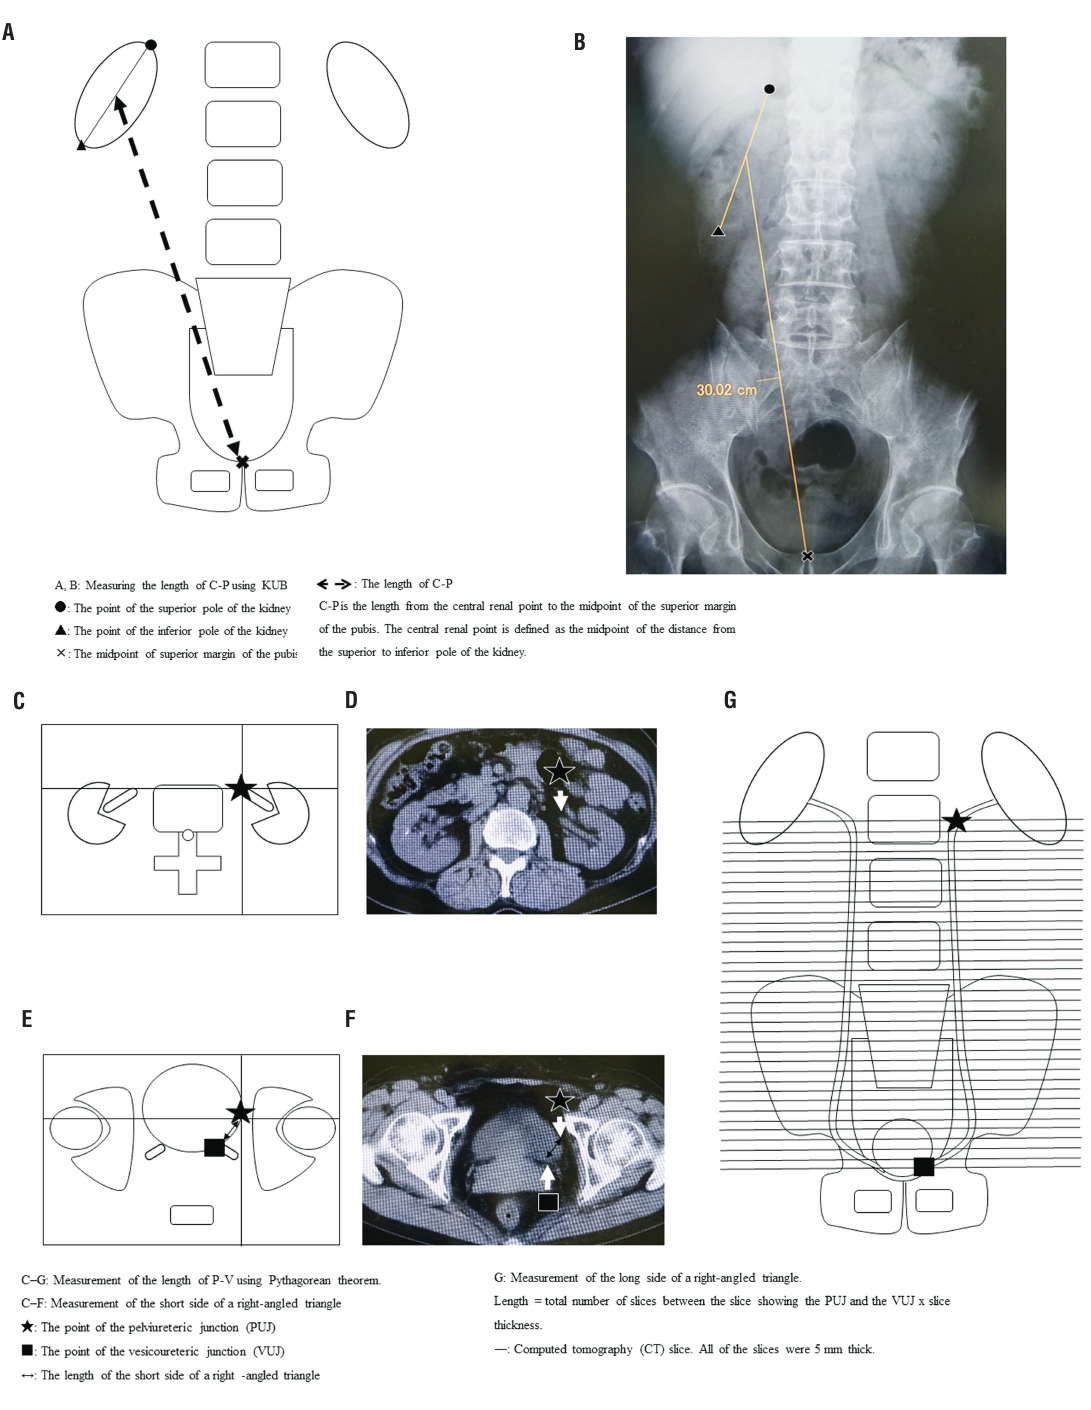
Figure 2 (A-G) - Measuring the length of C-P and